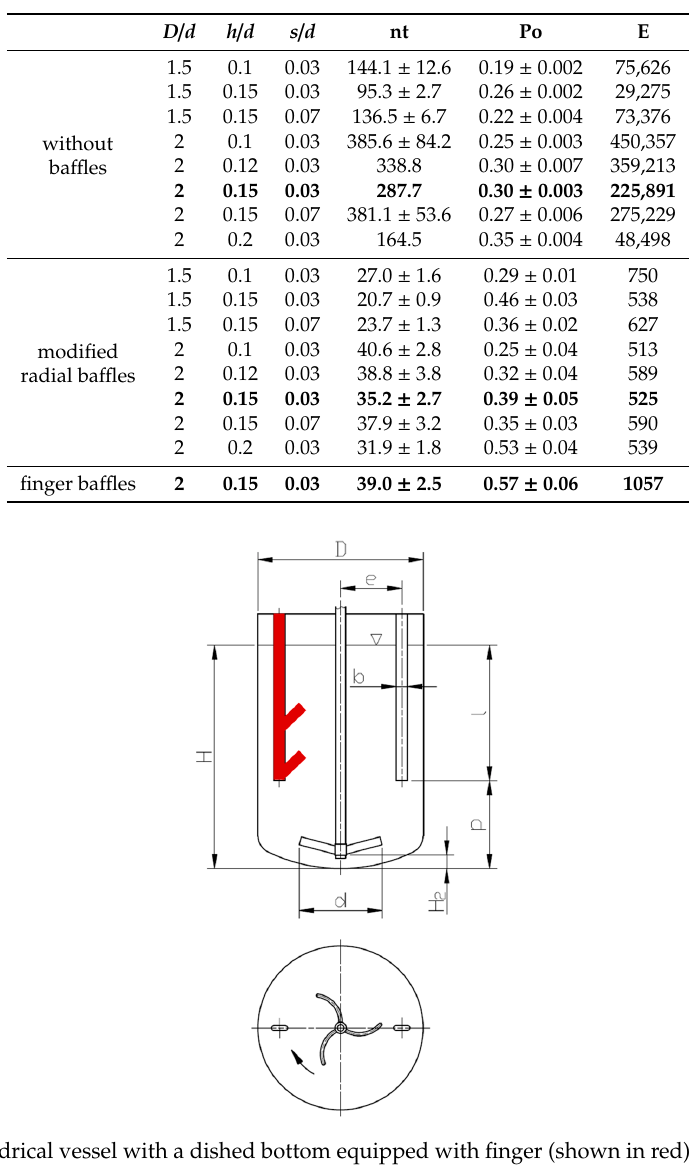
Table 4. Homogenization e ff ects of three-blade (radial) impellers with curved blades in a cylindrical vessel with a dished bottom [20].